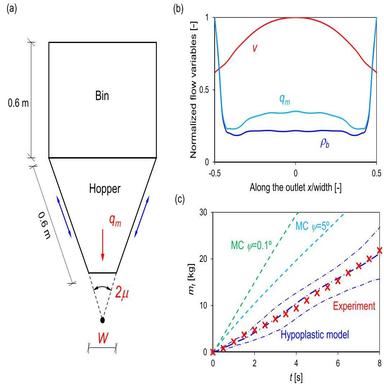
(a) Geometry of the wedge-shaped hopper with an upper bin for both the numerical simulation and the physical tests. The outlet size is controlled by sliding the hopper walls. (b) Normalized representative flow rate qm, bulk density ρb, and velocity v profiles along the width of outlet. (c) Comparison of predicted cumulative mass discharged mt from the G-B model (dot-dashed lines) and the M-C model (dashed lines) against experimental measurements (red 'x's) for W = 60 mm and μ = 30∘ .